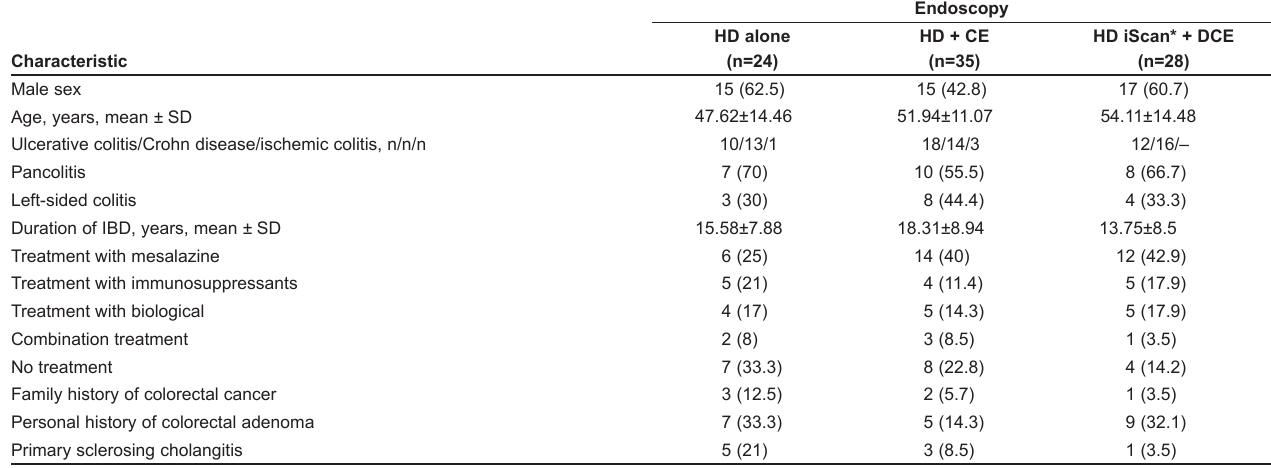
TAbLe 1 Demographic characteristics in each group of inflammatory bowel disease (IbD) patients